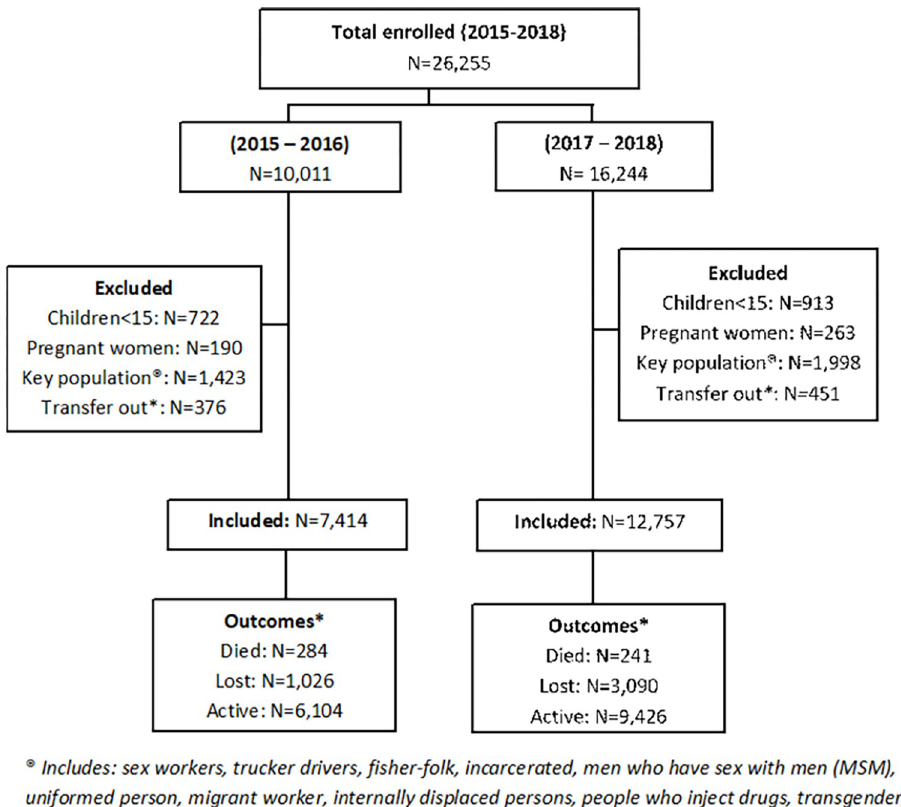
Fig 1. Consort chart showing number of HIV patients and their six months follow up outcomes at 11 TASO health facilities in Uganda for PLHIV enrolled in care in the period 2015–2018.